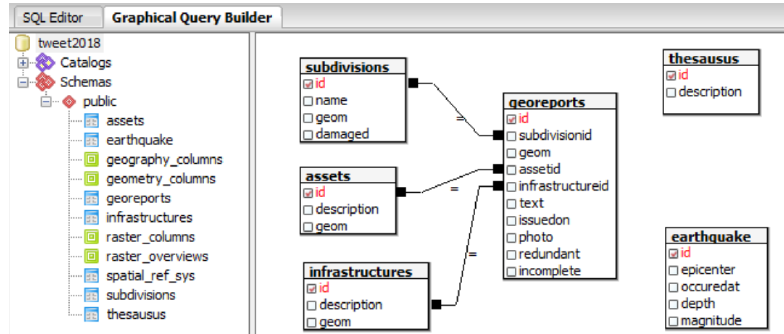
Figure 7. The Geo-DB tables and their relationships.